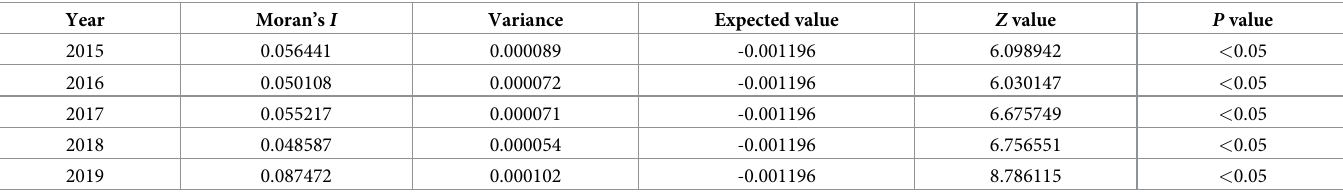
Table 2. Global autocorrelation analysis of mountain-type zoonotic visceral leishmaniasis incidence in 6 provences, China from 2015 to